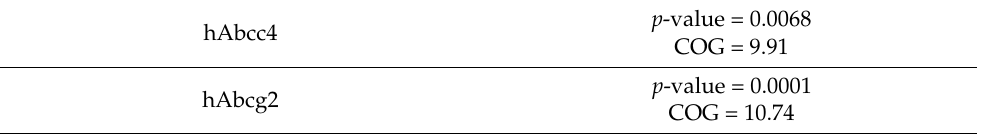
Figure 3. CircWave analysis of hAbcc4 and hAbcg2 expression profile in the HIBCPP cells. The represented curve indicates a statistically significant rhythm (CircWave, p < 0.05). Table 2. Significance ( p -value) and center of gravity (COG) values for hAbcc4 and hAbcg2 determined by CircWave